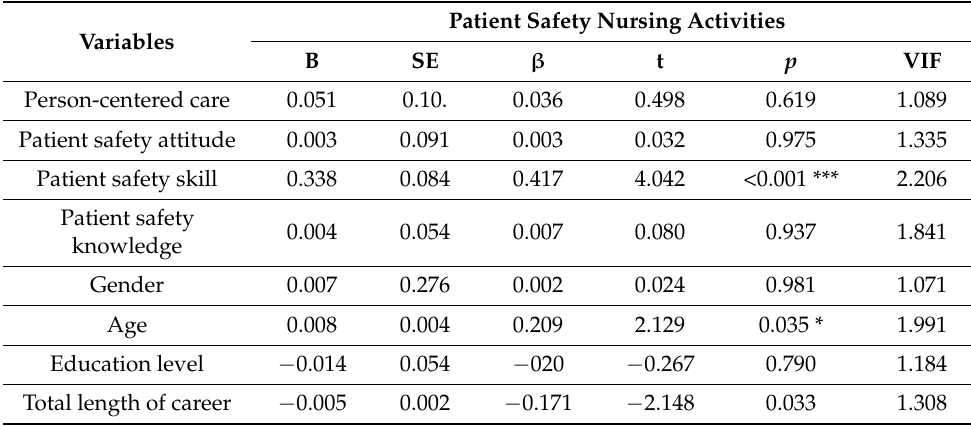
Table 5. Factors influencing patient safety nursing activities ( N =